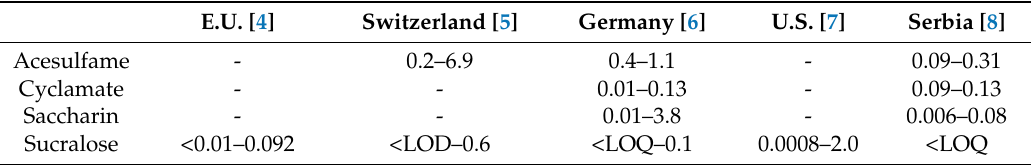
LOD: Limit Of Detection, LOQ: Limit Of